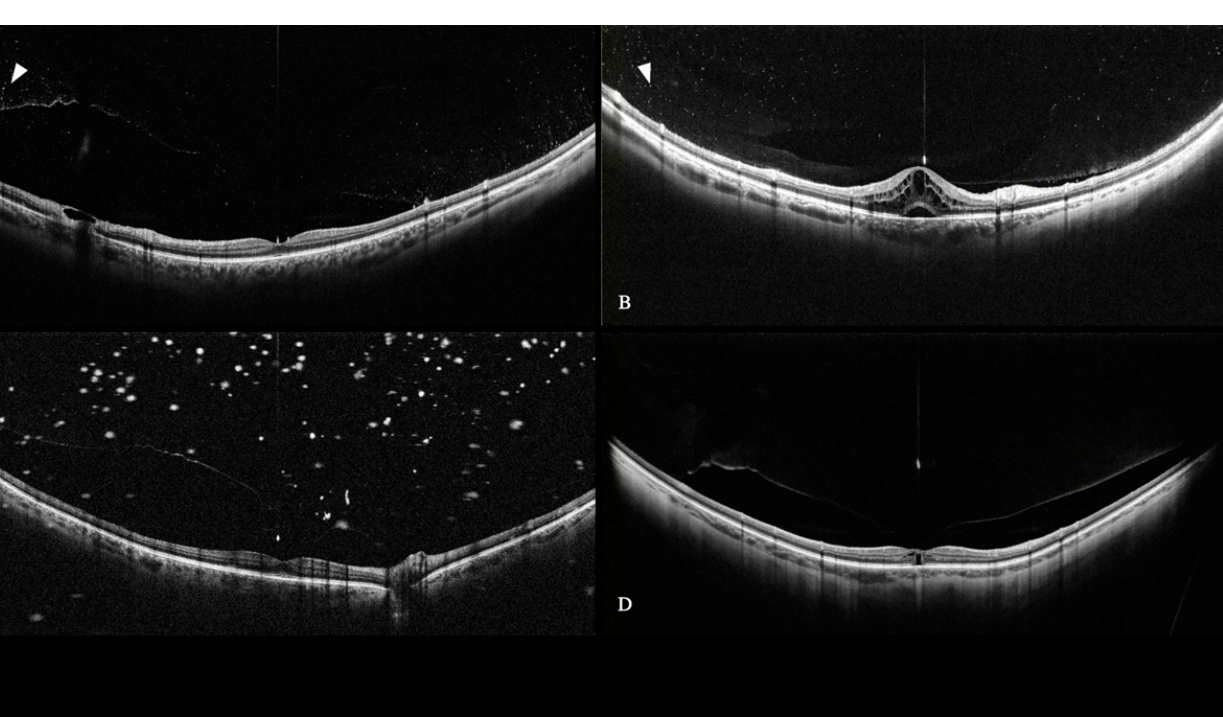
Figure 1. WF SS-OCT shows vitreous cellularity (arrowheads) in toxoplasma retinitis ( A ) and bilateral macular and optic nerve edema secondary to Behçet disease ( B ). Asteroid hyalosis induces bigger and hyper-reflective vitreous opacities ( C ). Vitreomacular Traction with subfoveal outer lamellar macular hole and initial foveal schisis. The vitreous is attached to the central fovea and at the equator ( D ).